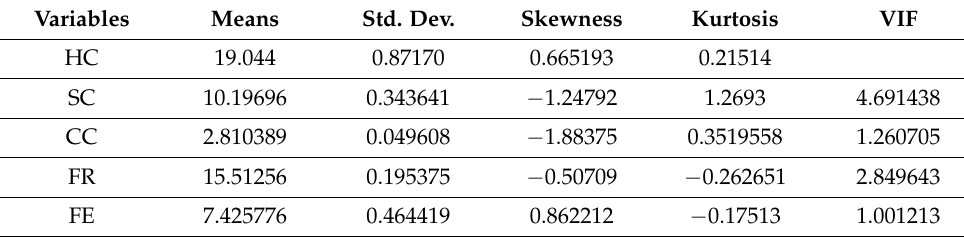
Table 3. Descriptive statistics of the model’s variables.